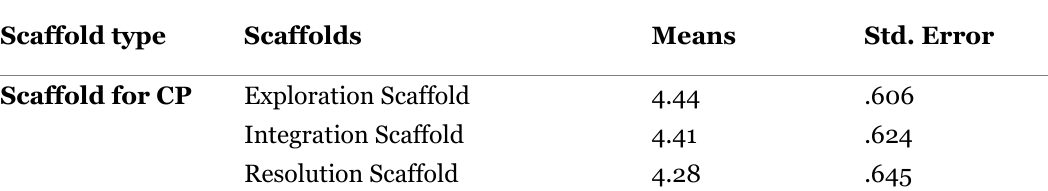
Survey Results on Effectiveness of Scaffolds for Cognitive Presence